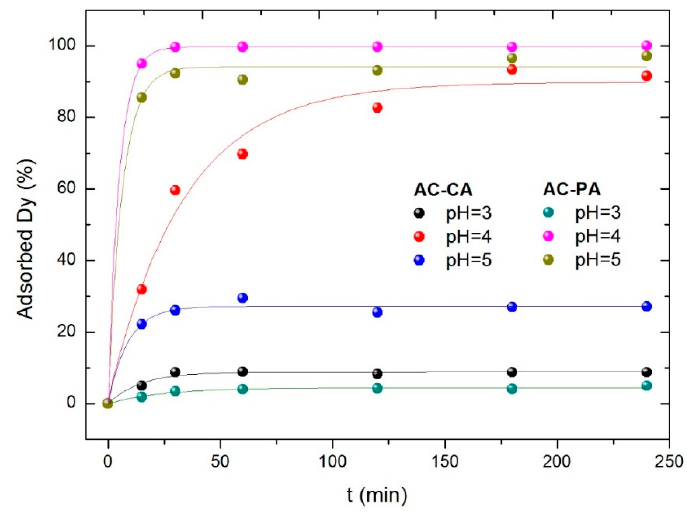
Figure 5. E ff ect of the solution pH for AC-CA and Figure 5. Effect of the solution pH for AC-CA and AC-PA.